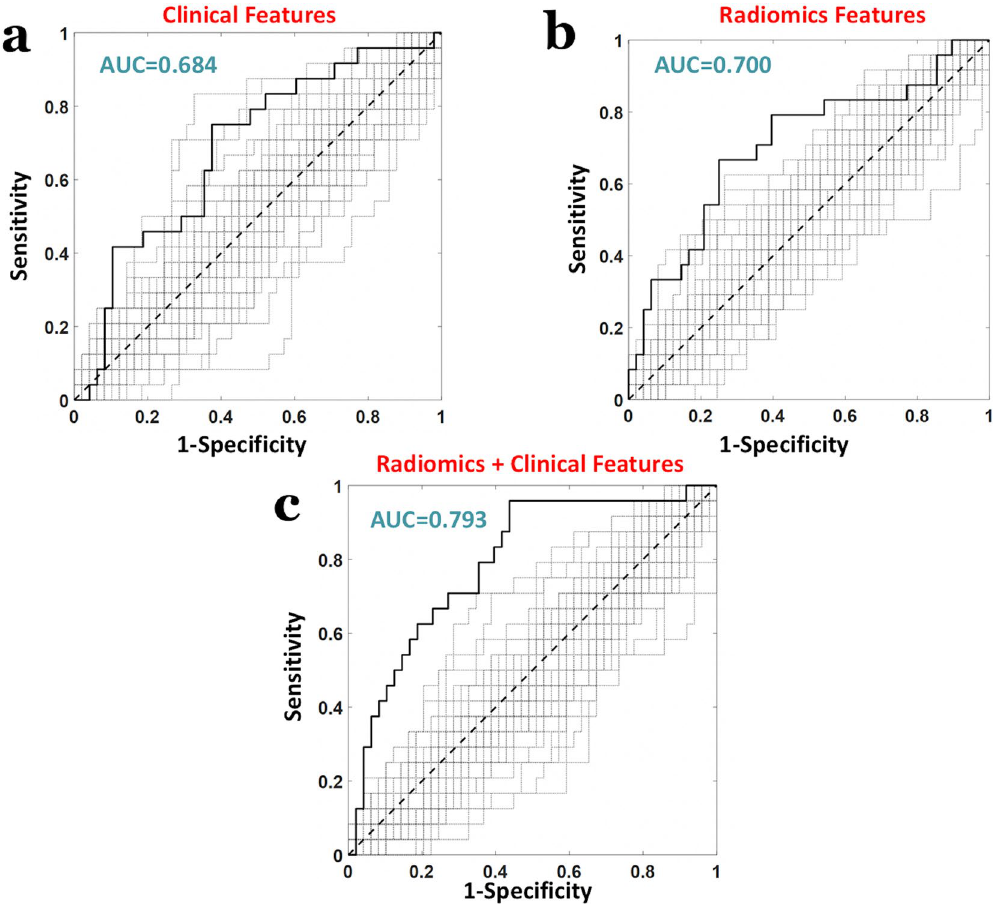
Figure 4. ROC analyses of the machine learning (PLS) classification performance predicting response to therapy (major pathological response as “positive”, non-major pathological response labelled as “negative”) when considering ( a ) standalone clinical features ( b ) standalone radiomic features and ( c ) combined clinical and radiomic